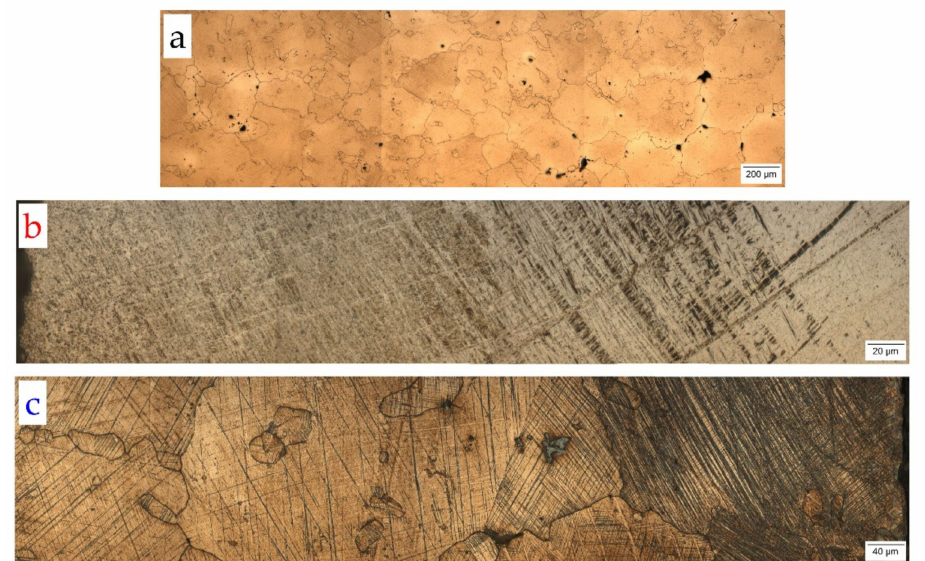
Figure 3. Optical micrographs of ( a ) bulk zone (zone 1); ( b ) outer surface (zone 2); ( c ) crushing surface (zone